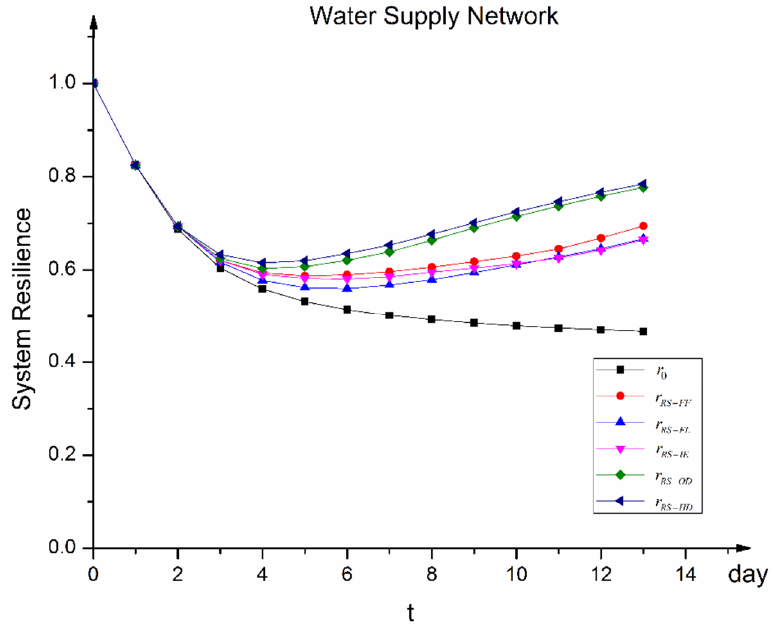
Figure 10. Resilience of the example water supply network after a large flood under five response